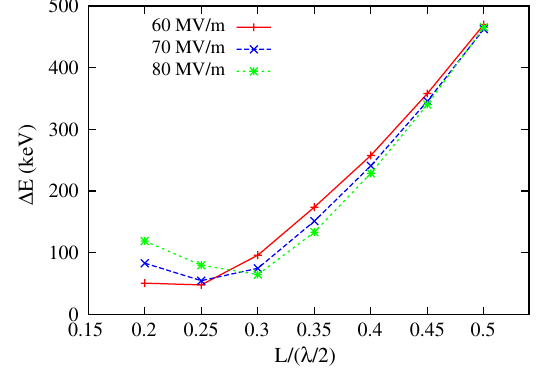
FIG. 8. Energy spread vs cathode cell length.